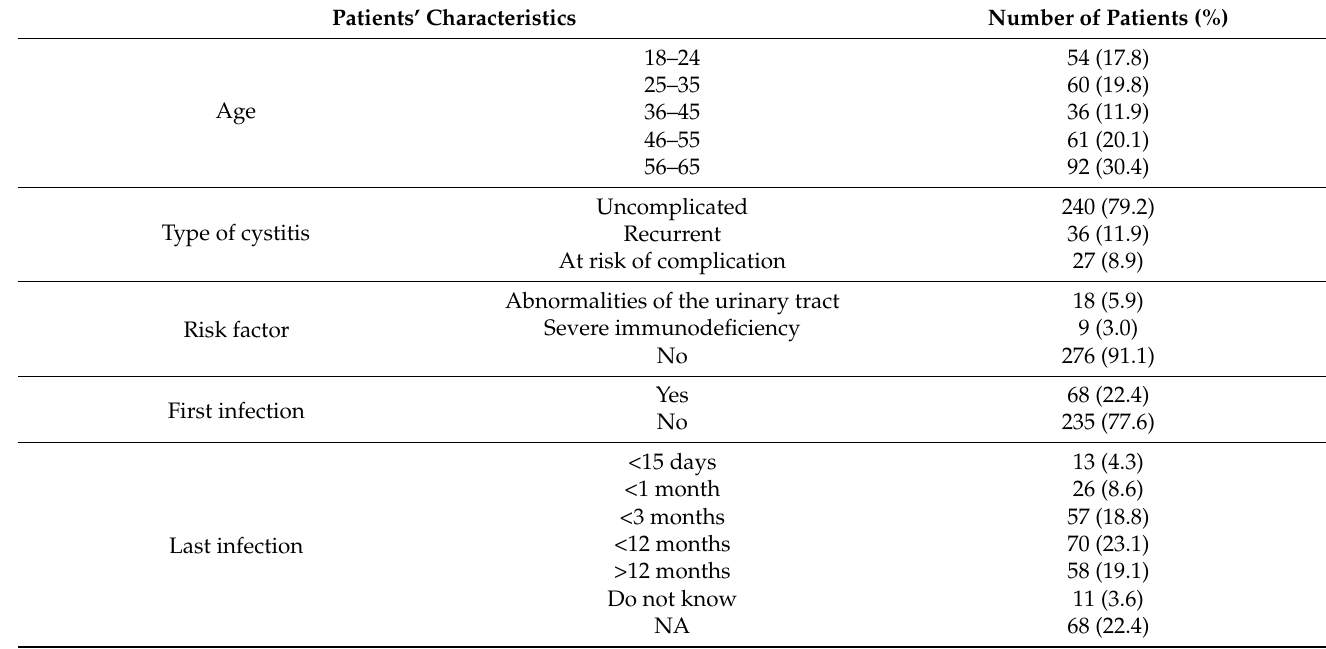
Table 2. Patients’ characteristics (n =